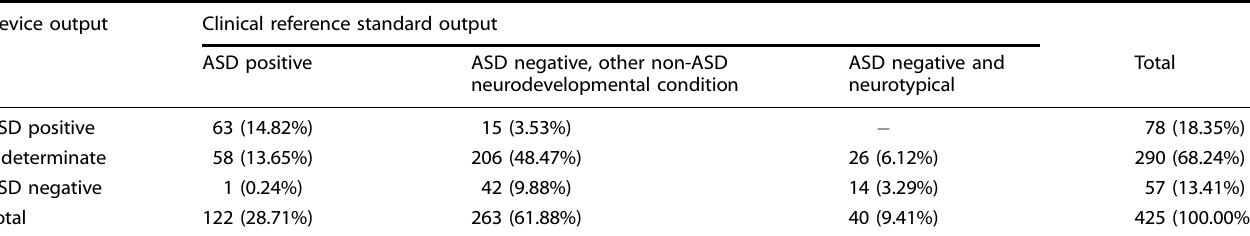
Table 3. Confusion matrix showing Device output compared to clinical reference standard